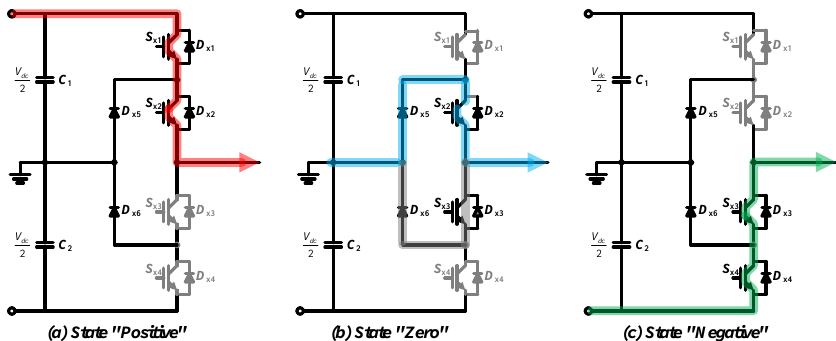
Figure 2. Current flow of three-level NPC inverter depending on the switching state.